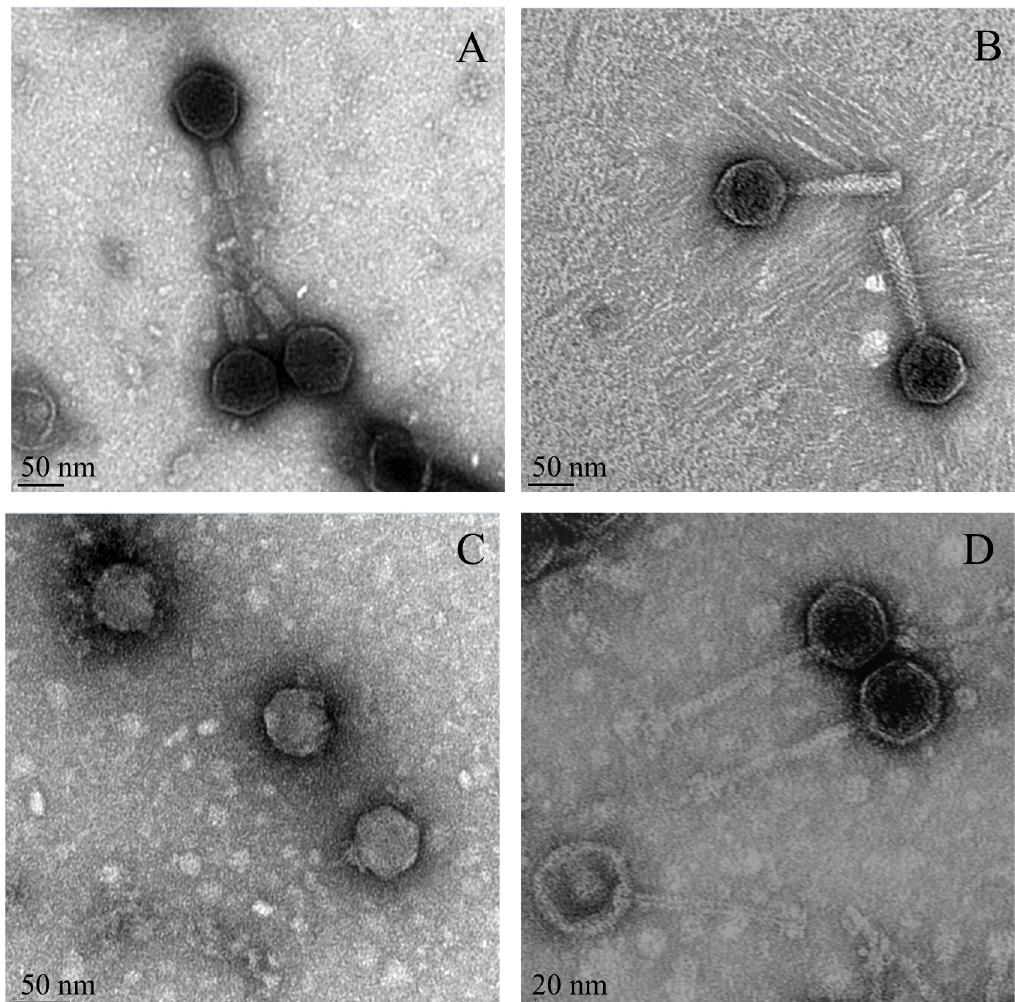
Fig 1. Morphology of isolated STEC-specific phages. The morphology of phage P1, belonging to the family Myoviridae , isolated from goat feces with tails in a contractile state (A); the morphology phage P3, belonging to the family Myoviridae , isolated from goat feces (B); the morphology of phage P2, belonging to the family Podoviridae , isolated from goat feces (C); the morphology of phage P7, belonging to the family Siphoviridae , isolated from soil (D). https://doi.org/10.1371/journal.pone.0234438.g001 PFGE was used to estimate genome size of the isolated phages (Table 3, S1 Fig). The positive control phage resulted in 2 bands, at 134 kb and 120 kb. The Myoviridae phages, primarily Table 3. The genetic and morphological characterization of the 14 isolated phages. Characterization Phage ID P1